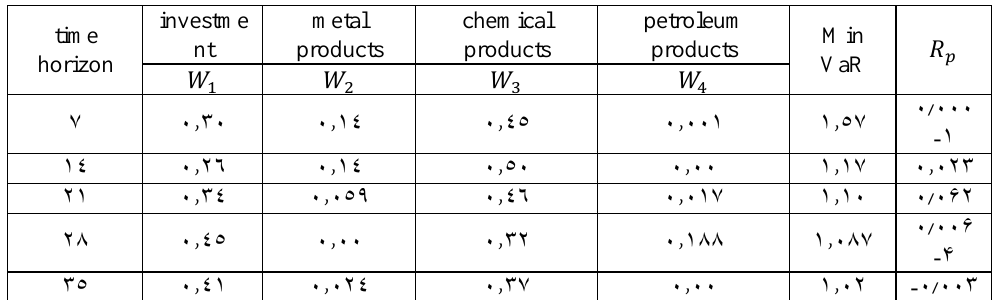
01 Table 16. Optimal non-regime portfolio for indices of the designated industries with a VaR